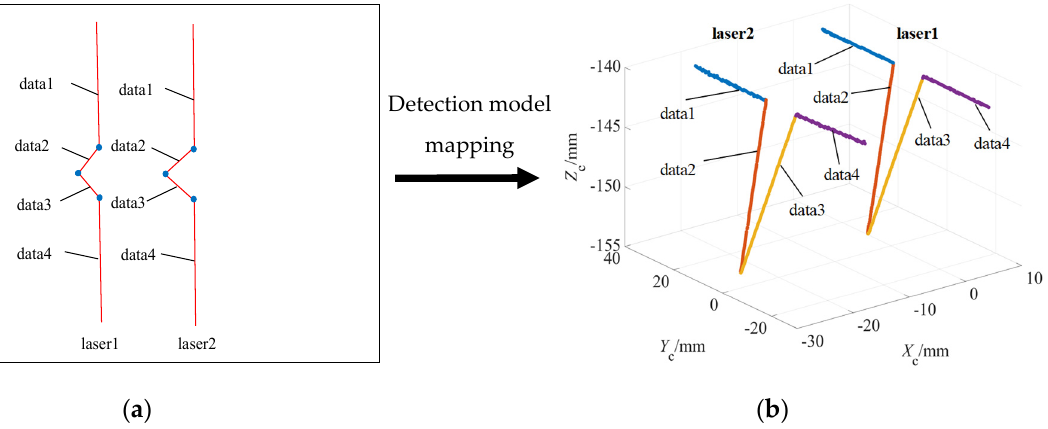
Figure 7. Data segmentation of modulated laser lines: ( a ) 2D data segmentation of laser lines image and ( b ) 3D data segmentation of laser lines.